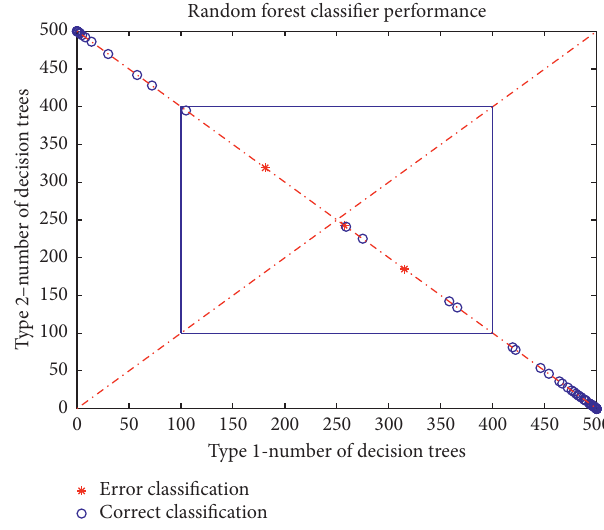
Figure 8: Predicting classification chart.